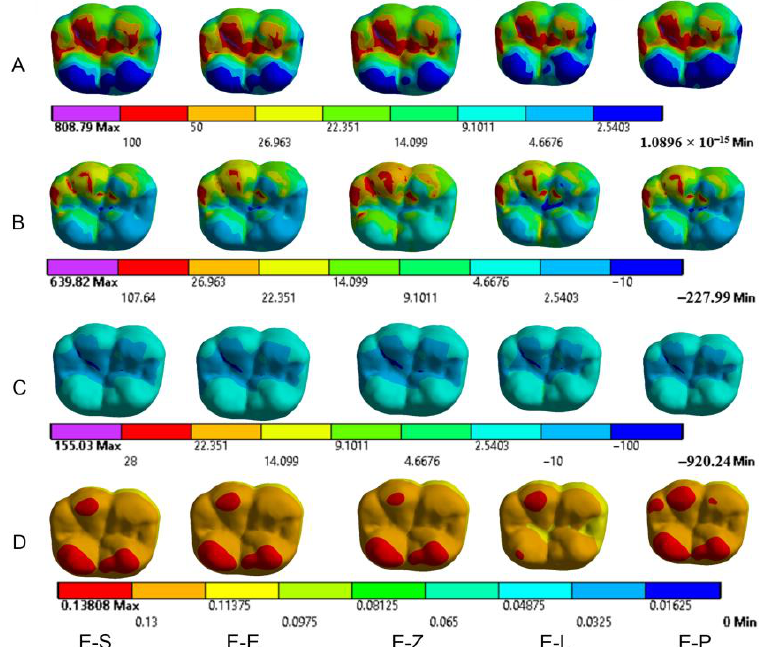
Figure 4. Stress distribution and displacement of endocrowns in all models under oblique loading. ( A ) von Mises stress, ( B ) maximum principal stress, ( C ) minimum principal stress and ( D ) displace- ceramic network model.